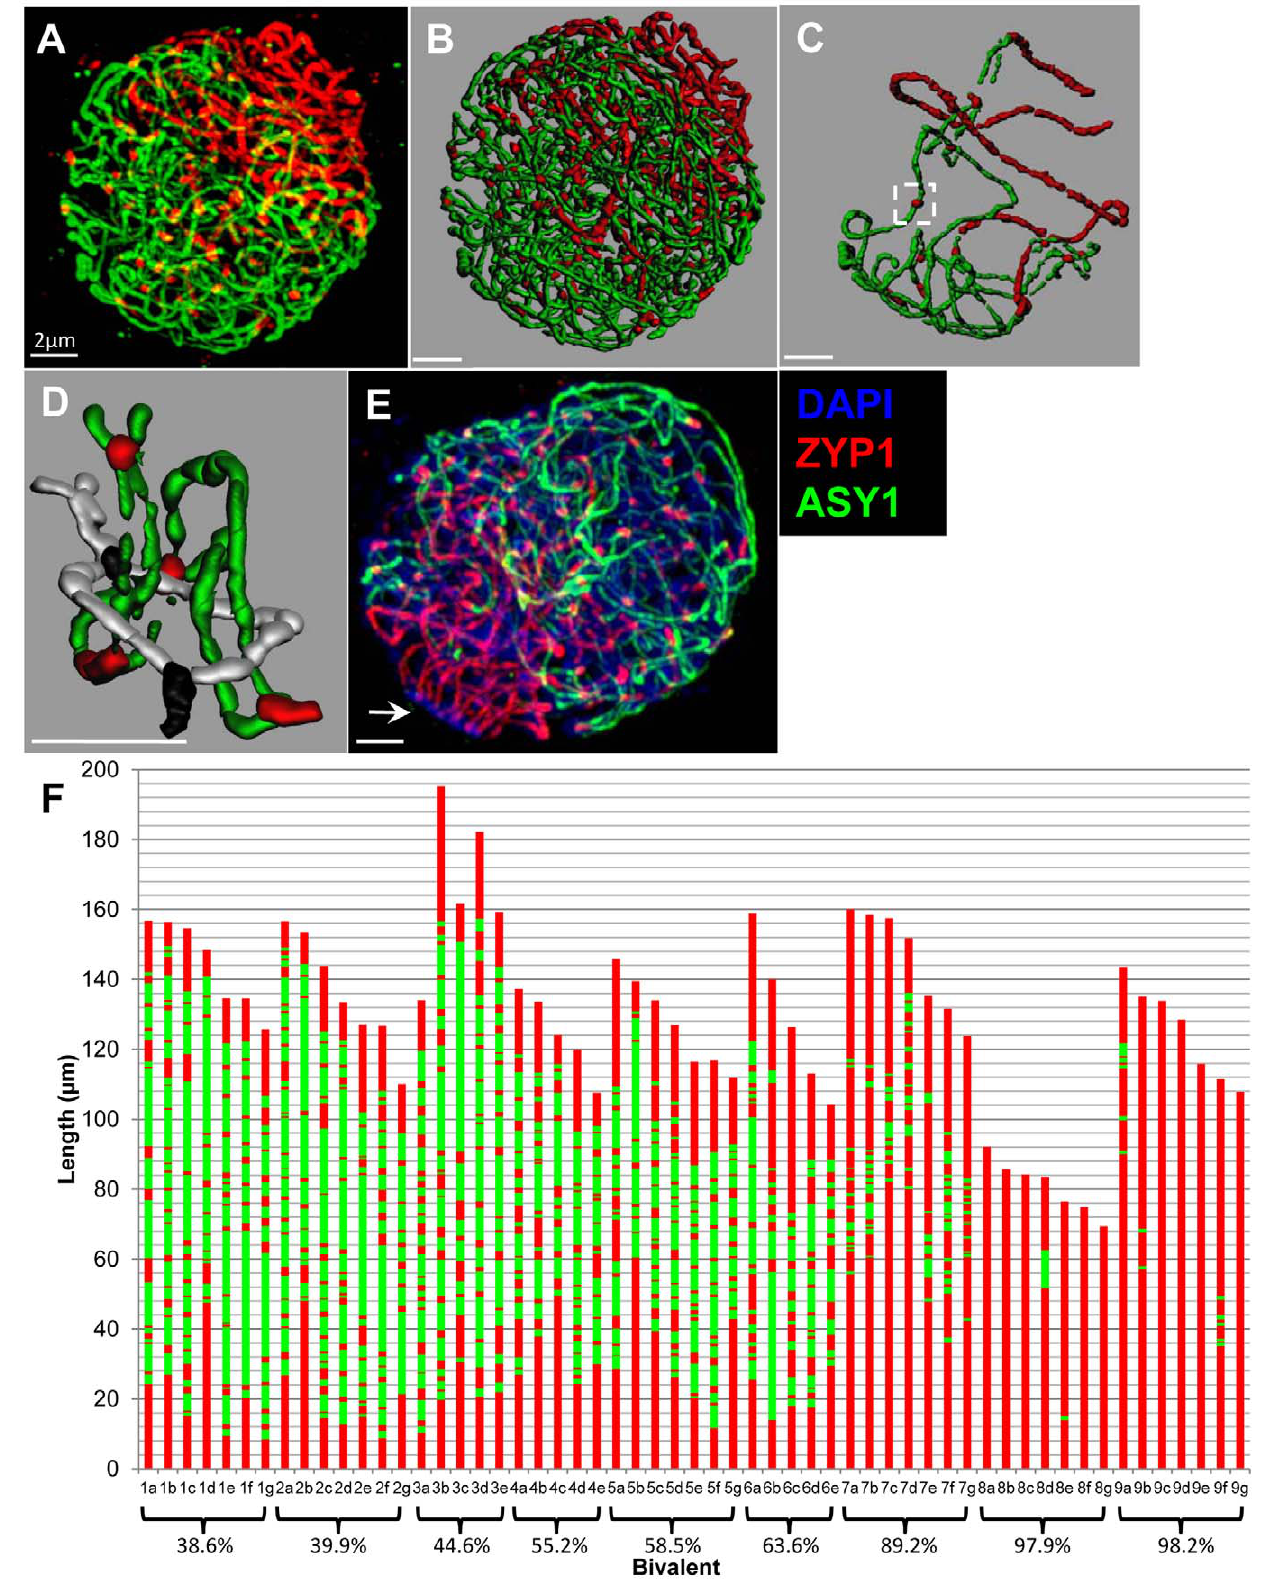
Figure 2. Analysis of synaptic progression during barley prophase I. (A & E) Deconvolved maximum projection of a zygotene nucleus embedded in polyacrylamide and captured using CLSM, showing ASY1 cores (green) and ZYP1 cores (red). (B) Zygotene nucleus shown in Figure 2A processed using Imaris with each of the seven synapsing bivalents isolated, showing generated surfaces for ASY1 (green) and ZYP1 (red). (C) A single